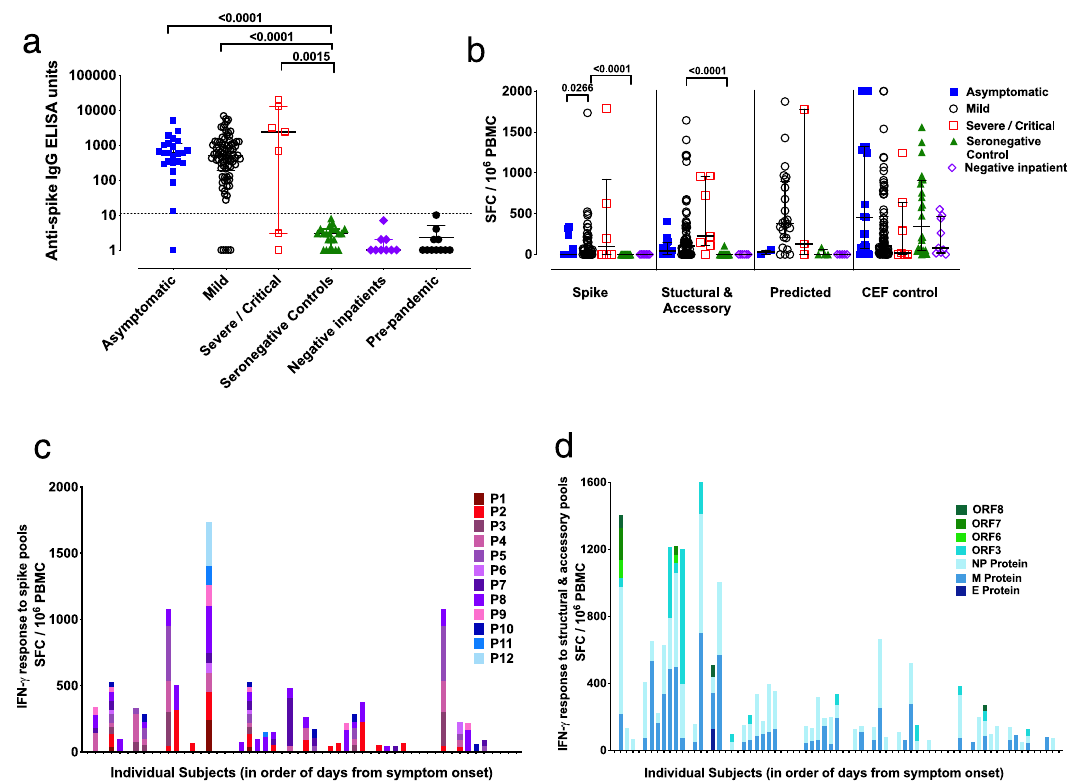
Fig. 1 Magnitude and breadth of SARS-CoV-2-speci fi c immune response. a Total anti-SARS-CoV-2 spike IgG antibody titres by indirect ELISA 29 in 22 seronegative controls, 24 asymptomatic and 82 mildly symptomatic healthcare workers (HCWs) with PCR-con fi rmed SARS-CoV-2 infection, 7 hospitalised patients with severe or critical PCR-con fi rmed SARS-CoV-2 infection, 9 PCR-negative inpatient controls, and 11 pre-pandemic controls. b Ex vivo IFN- γ ELISpot showing the effector T cell responses to summed SARS-CoV-2 peptide pools spanning spike, accessory and structural proteins (E, M, NP, ORF 3, ORF6, ORF7 and ORF8), in silico-predicted pools 10 and the CEF T cell control panel in cohort groups as in a . c Ex vivo IFN- γ ELISpot showing the magnitude and breadth of effector T cell responses in 54 individual volunteers to 12 SARS-CoV-2 spike peptide pools (numbered P1 to P12) and d M, NP and accessory proteins ORF 3, ORF6, ORF7 and ORF8 in 73 HCWs convalescent with mildly symptomatic SARS-CoV-2 infection. X axis shows number of days from onset of symptoms (not to scale), with blank columns representing zero response in the individual tested at that time-point. SFC/10 6 PBMC = spot-forming cells per million peripheral blood mononuclear cells, with background subtracted. Plots show median with error bars indicating ± IQR. Kruskal – Wallis one-way ANOVA, with Dunn ’ s multiple comparisons test, was performed. Two-tailed P -values < 0.05 are shown on plots with Supplementary Table 3 showing full Kruskal – Wallis one-way ANOVA, with Dunn ’ s multiple comparisons test for b . Source data are available in the source data fi